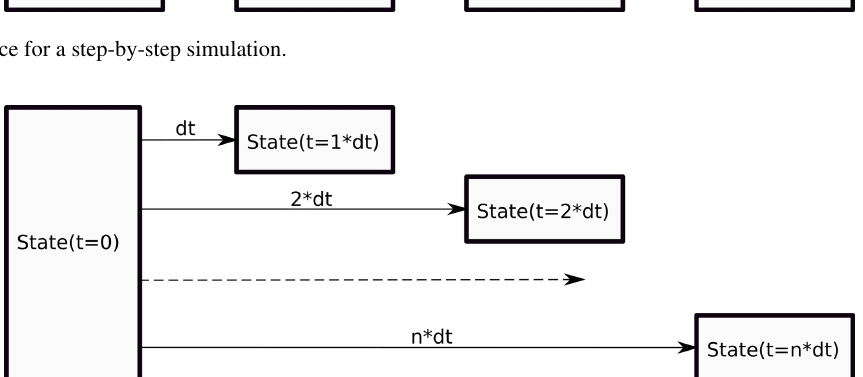
Figure 6. Time advance for a one-step